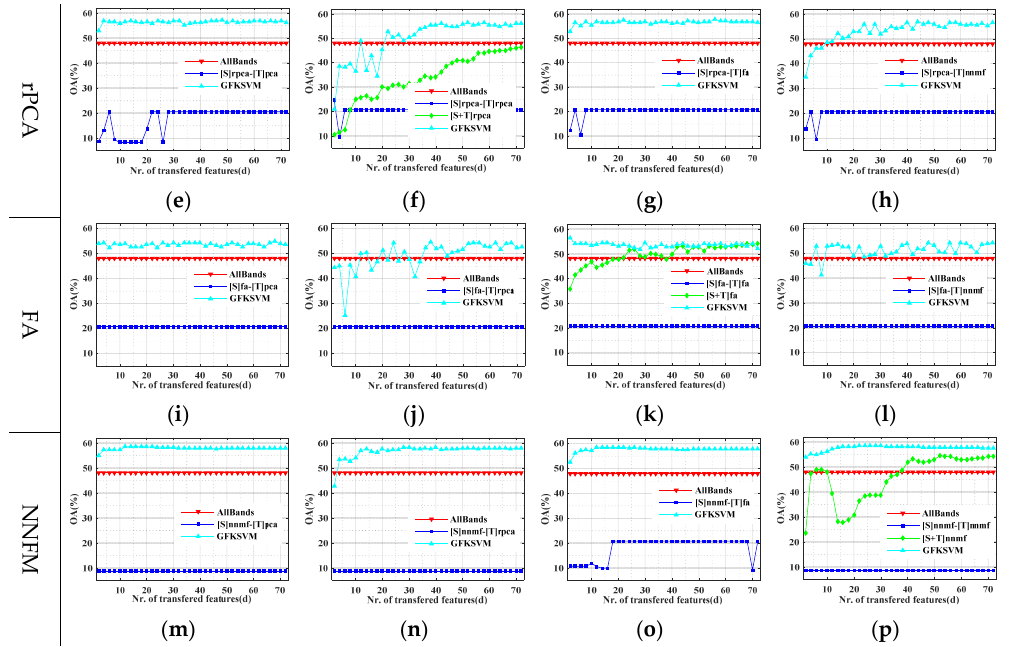
Figure 13. Classification accuracy curves for GFKSVM with various subspace feature transfer approaches on Houston data (Left site → Right site). ( a ) PCA-PCA; ( b ) PCA-rPCA; ( c ) PCA-FA;